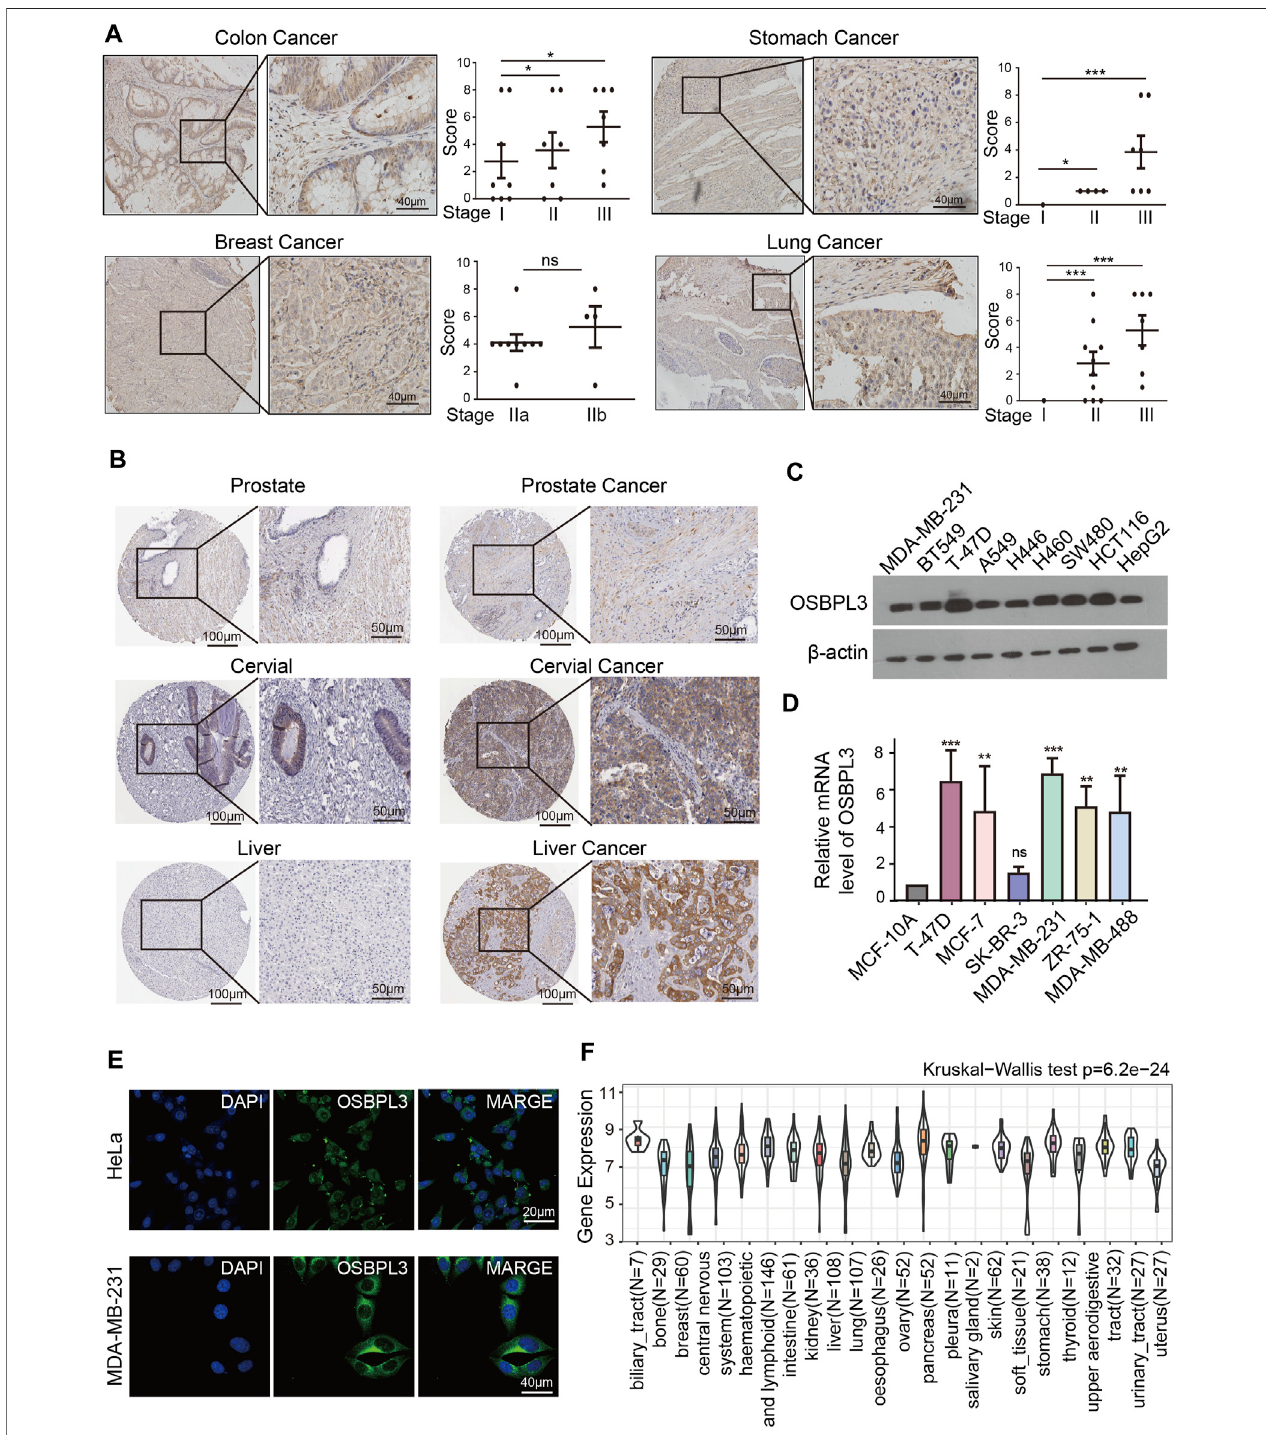
FIGURE 2 | Expression and location of OSBPL3 in a variety of cancer tissues and cells. (A) OSBPL3 expression of multi-tissue arrays of colon cancer, stomach cancer, breast cancer, and lung cancer by IHC staining and statistical analysis of the relationship of OSBPL3 expression with tissue status. (B) OSBPL3 expression in different tumor tissues of prostate cancer, cervical cancer, liver cancer, and lung cancer by IHC staining from the HPA (Human Protein Atlas) database. (C) IF assays for subcellular localization of OSBPL3 in cervical cancer HeLa (up) and breast cancer MDA-MB-231 (down) cell lines (blue: nucleus; green: OSBPL3). (D) The protein expression levels of OSBPL3 in nine cancer cell lines (MDA-MB-231, BT549, T47D, A549, H446, H460, SW480, HCT116, and HepG2) were detected by WB. (E) The mRNA expression levels ofOSBPL3 in sixbreast cancer cell lines (T-47D, MCF-7, SK-BR-3, MDA-MB-231, MDA-MB-468, and ZR-75-1) and one normal breast ductal epithelialcellline(MCF-10A) weredetectedbyqRT-PCR(down). (F) Geneexpression invarioustumor cellsfromtheCCLEdatabase.* p < 0.05;** p < 0.01;*** p < 0.001.